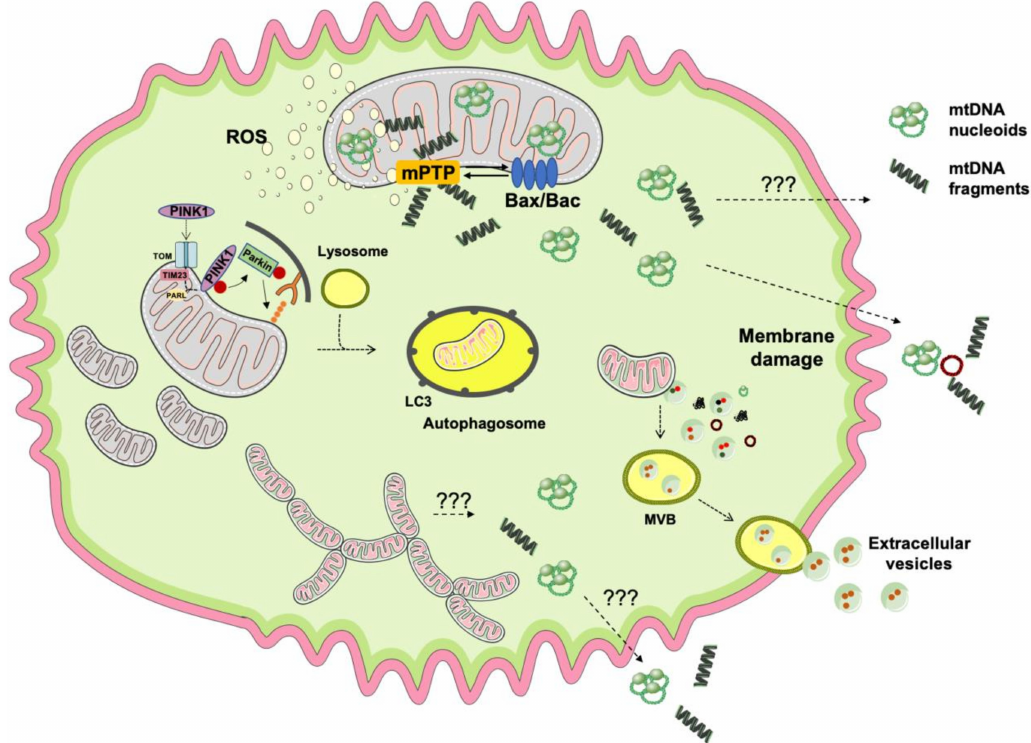
Figure 1. Schematic representation of the pathways involved in mitochondrial DNA unloading. Under several stressors (e.g., mitochondrial dysfunction and consequent reactive oxygen species (ROS) production, viral and bacterial infections), several types of damage are inflicted to mitochondrial DNA (mtDNA) and a set of signaling pathways are activated to promote mitochondrial recovery or demise depending on the damage severity. (1) In the setting of ROS bursts, mtDNA oxidation and fragmentation occur concomitant with mitochondrial permeability transition pore (mPTP) opening. If the extent of damage overwhelms the mitochondrial quality control system, persistent mPTP opening allows extrusion of oxidized mtDNA fragments into the cytosol. Meanwhile, the deployment of apoptosis via Bax / Bak signaling enables the extrusion of mtDNA nucleoids consisting of mitochondrial transcription factor A-bound mtDNA. (2) Transient opening of mPTP and ROS production trigger mitochondrial fission and mitophagy to clear dysfunctional mitochondria. Damaged organelles are sequestered into autophagosomes that subsequently fuse with lysosomes for content disposal. Herein, a set of DNases execute mtDNA cleavage. (3) Hyperfragmented or hyperfused mitochondria also deliver mtDNA into the cytosol from which it can be extruded into the extracellular space through unknown mechanisms. (4) If mitochondria are only mildly damaged, mtDNA and other mitochondrial constituents can be shuttled outside the cell via extracellular vesicles (EVs). EVs of mitochondrial origin (i.e., mitochondrial derived vesicles) may fuse with multivesicular bodies (MVBs) and deliver their cargo in the extracellular space for signaling purposes. (5) Following cell injury or necrosis, the damaged plasma membrane may represent a route for the delivery of mtDNA and other cellular components outside of the